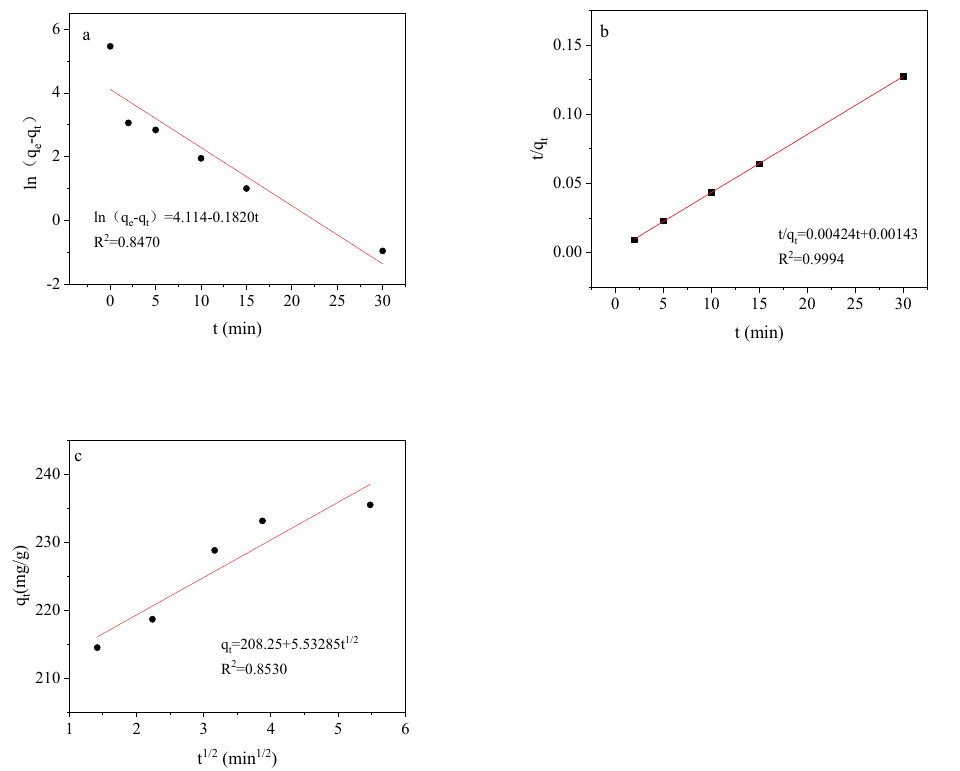
Figure 8. Pseudo-first-order ( a ), pseudo-second-order ( b ), and intra-particle diffusion model ( c ) at 298 298 K.